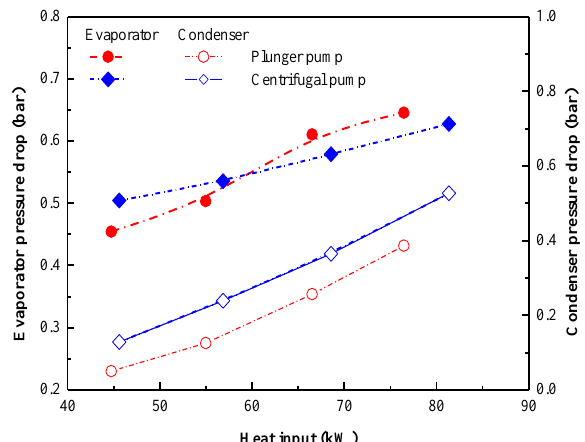
Figure 10. Condenser and evaporator pressure drop with heat input using the plunger pump and centrifugal pump.